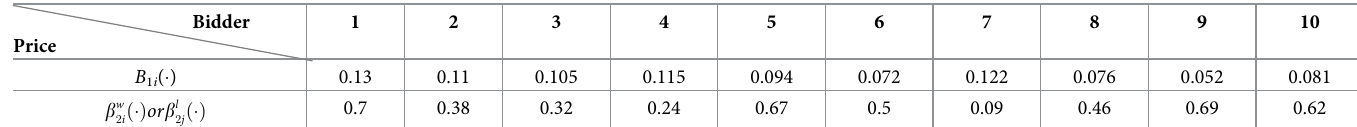
Table 3. Equilibrium bidding price of bidders during both stages. Bidder Price